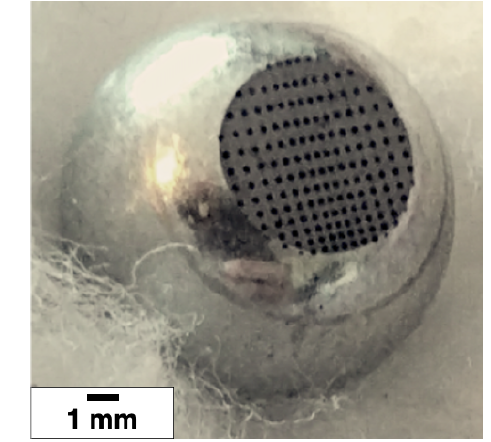
Figure 2. Microtextured sample - Diagonal